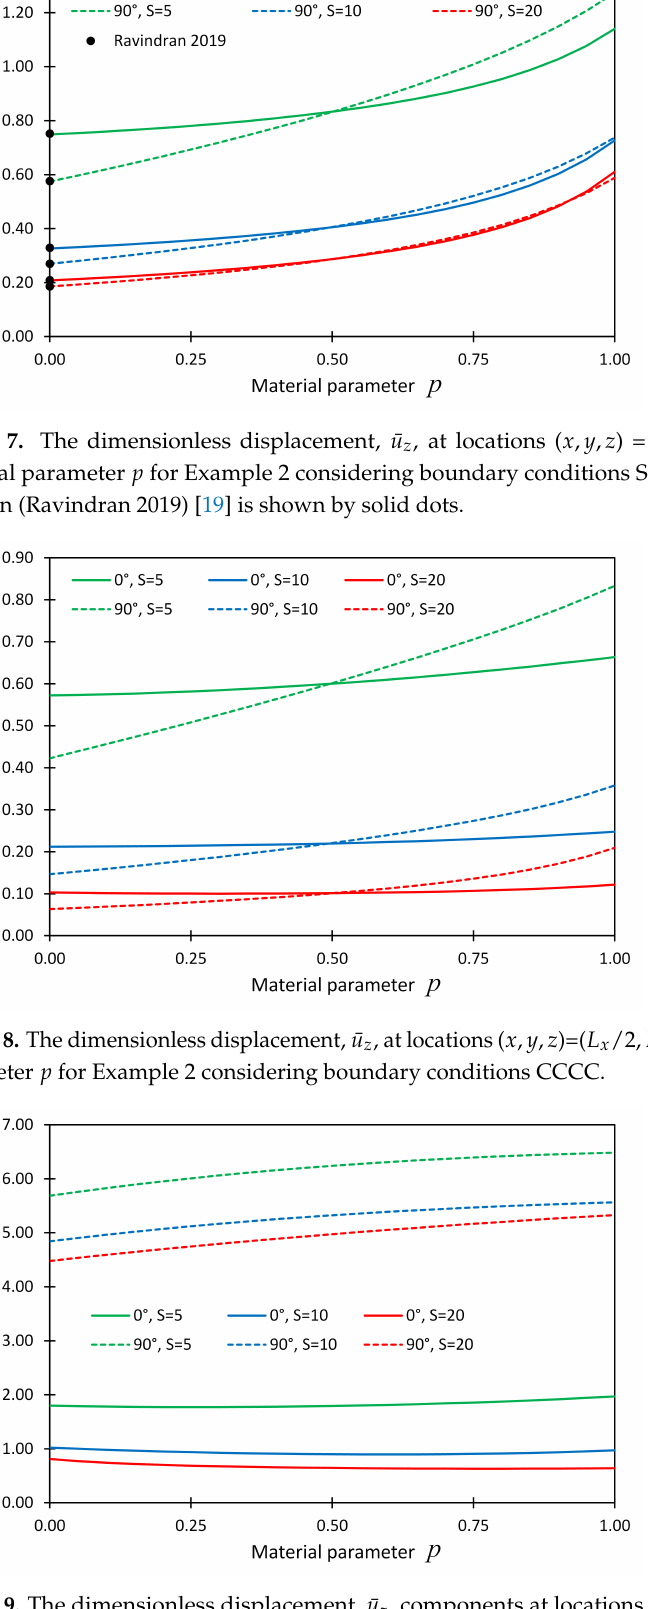
Figure 9. The dimensionless displacement, ¯ u z , components at locations ( x , y , z )=( L x /2, L y /2, L z /2) versus material parameter p for Example 2 considering boundary conditions